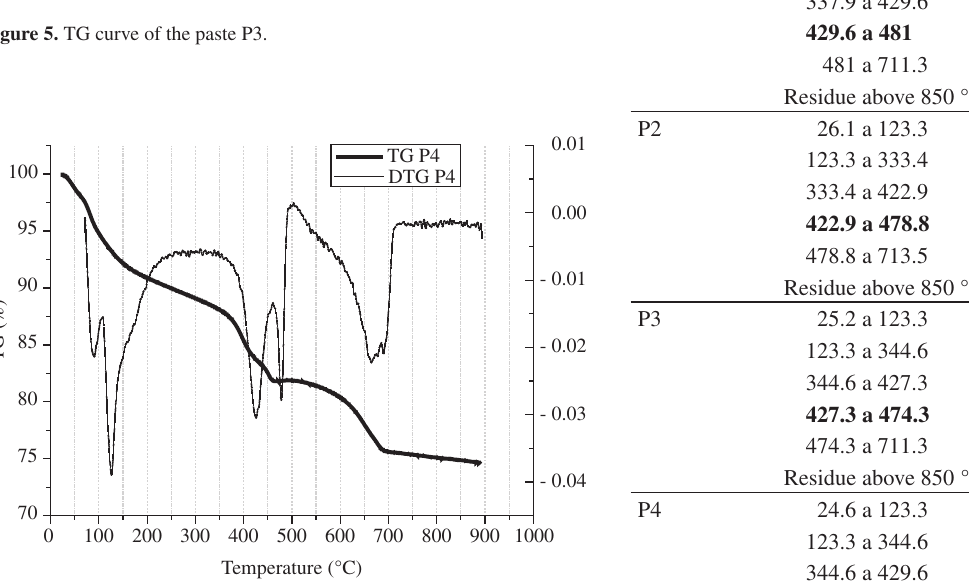
Figure 6. TG curve of the paste P4.